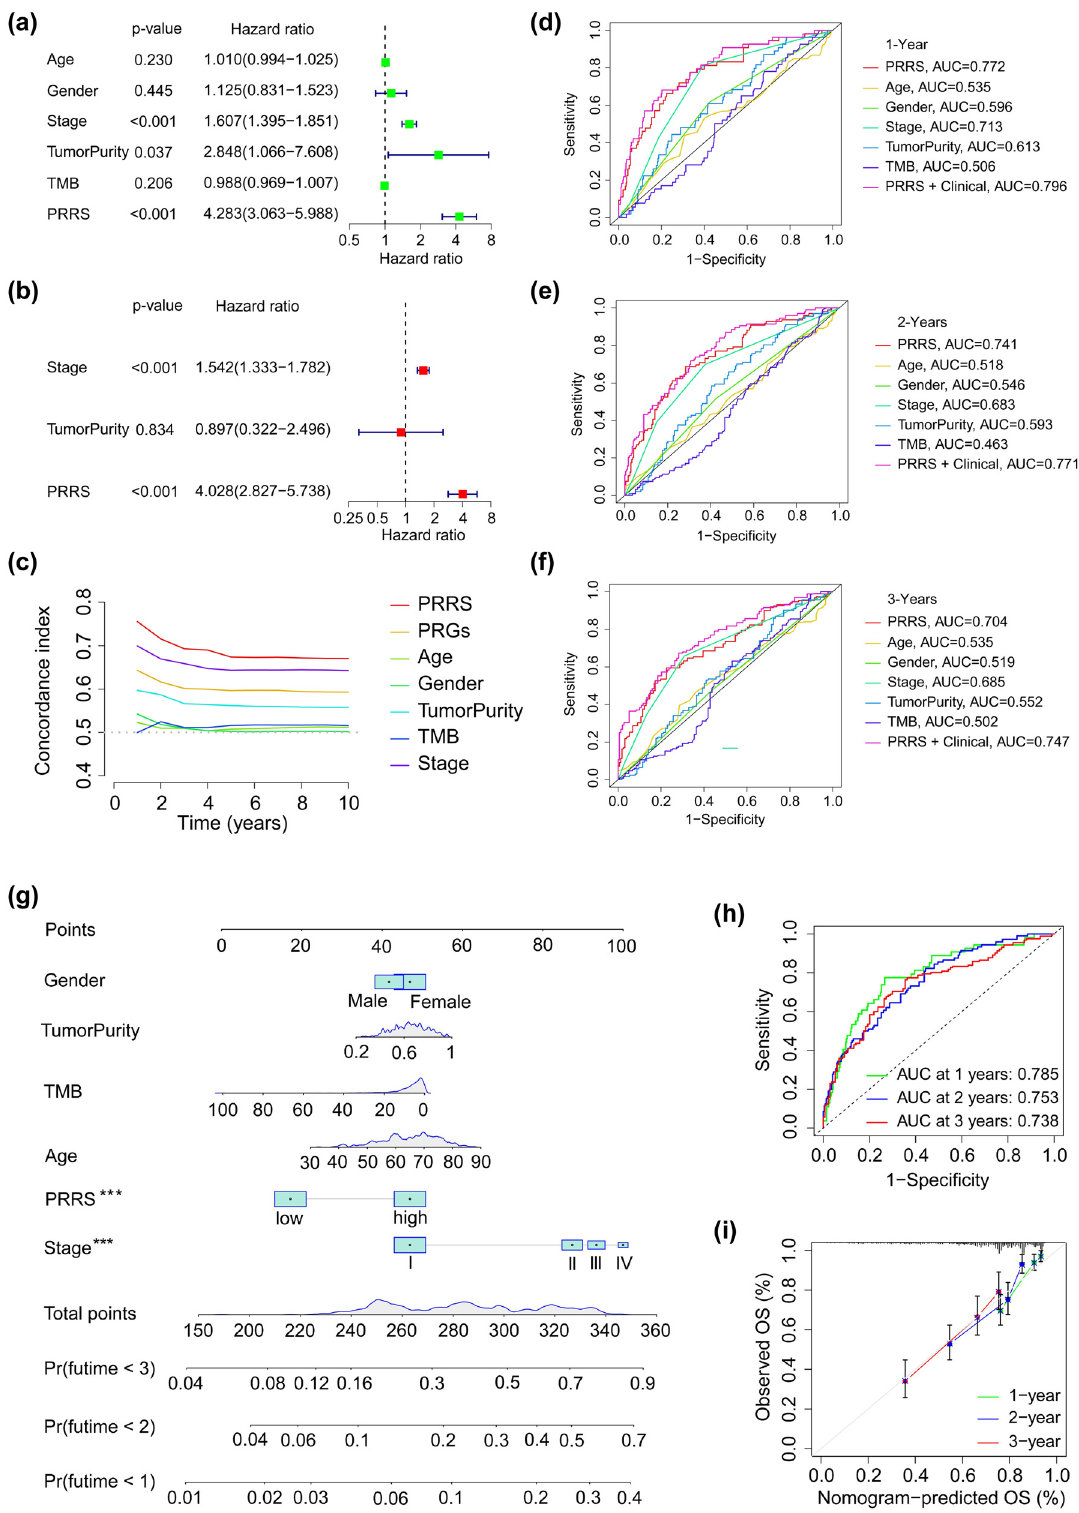
Figure 9: Development and veri fi cation of nomogram. ( a and b ) Univariate and multivariate regression analyses of the correlation between PRRS and clinical characteristics regarding OS in the TCGA - LUAD cohort. ( c ) C - index curves of PRRS and clinical features. ( d – f ) Time - dependent ROC analyses of PRRS and, or clinical features regarding the OS and survival status in the TCGA_LUAD cohort. ( g ) Nomogram is based on gender, age, tumor purity, TMB, PRRS, and stage. ( h ) Time - dependent ROC analyses of the nomogram regarding the OS and survival status in the TCGA_LUAD cohort. ( i ) Calibration curves of the nomogram between predicted and observed 3 - , 5 - and 10 - year OS in the TCGA_LUAD